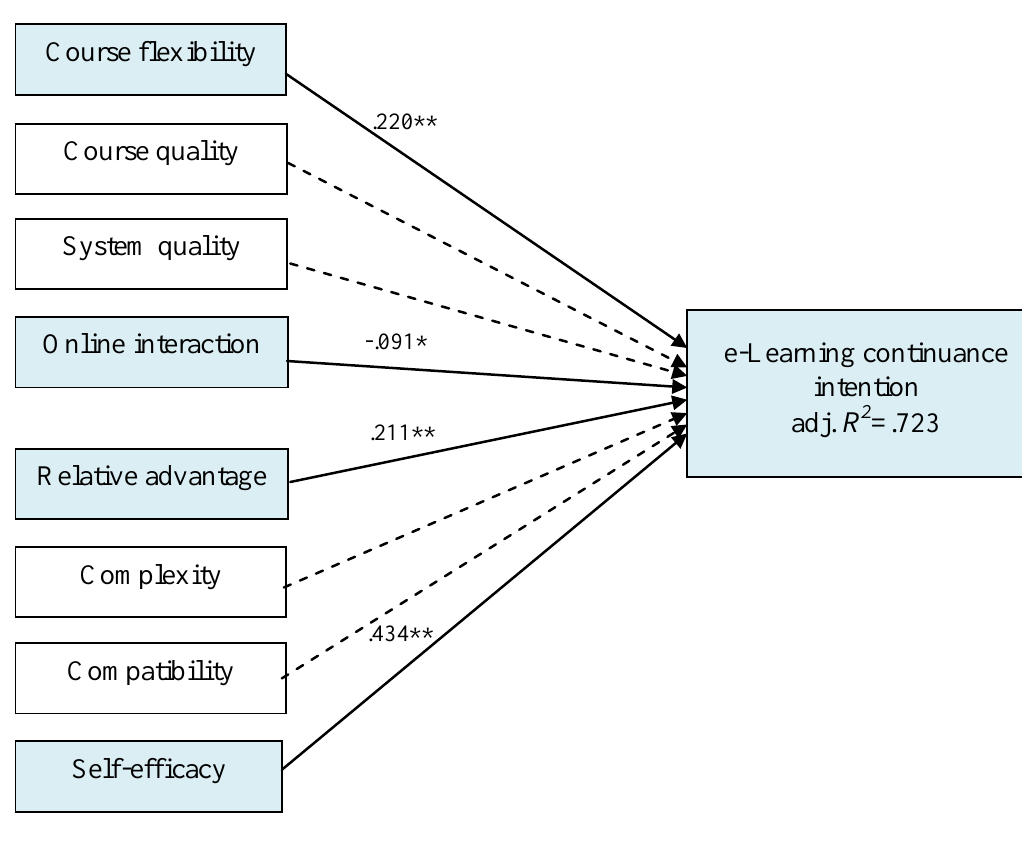
Figure 4. Model of factors affecting learners' e-learning continuance intention for the high- degree-of-participation group. Note: Solid lines represent significant results, whereas dotted lines represent insignificant results; * p < .05, ** p < .01